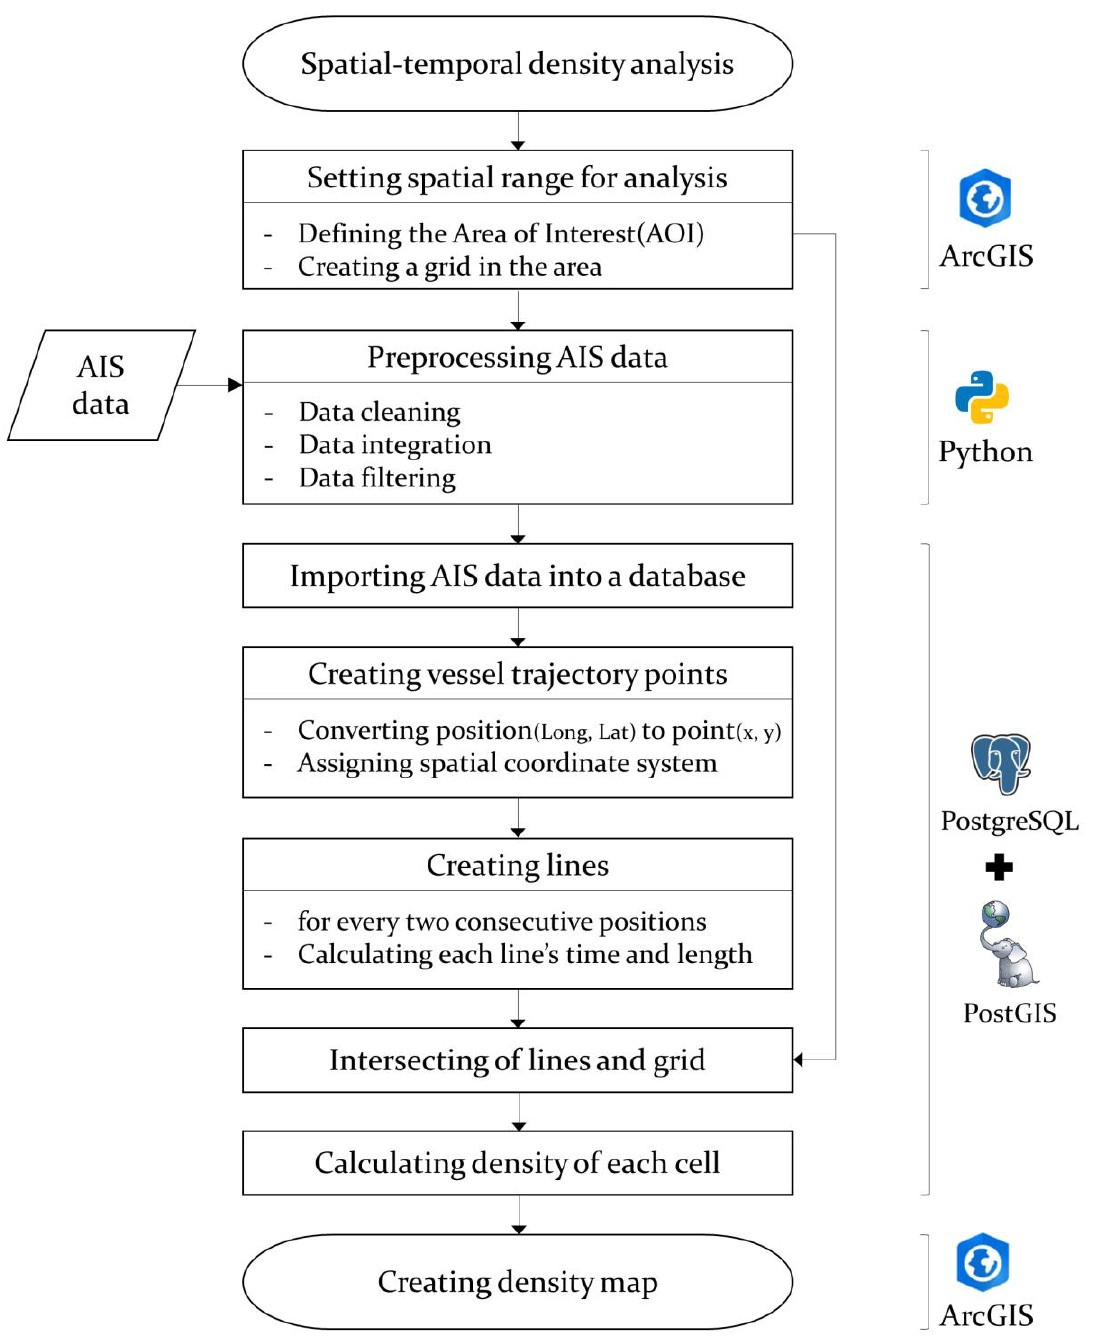
Figure 3. Flowchart of the spatial-temporal density analysis.